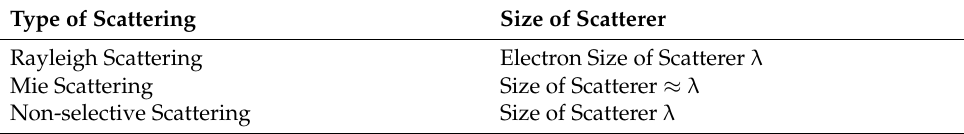
Table 4. Relative size of scatterer determines the type of atmospheric